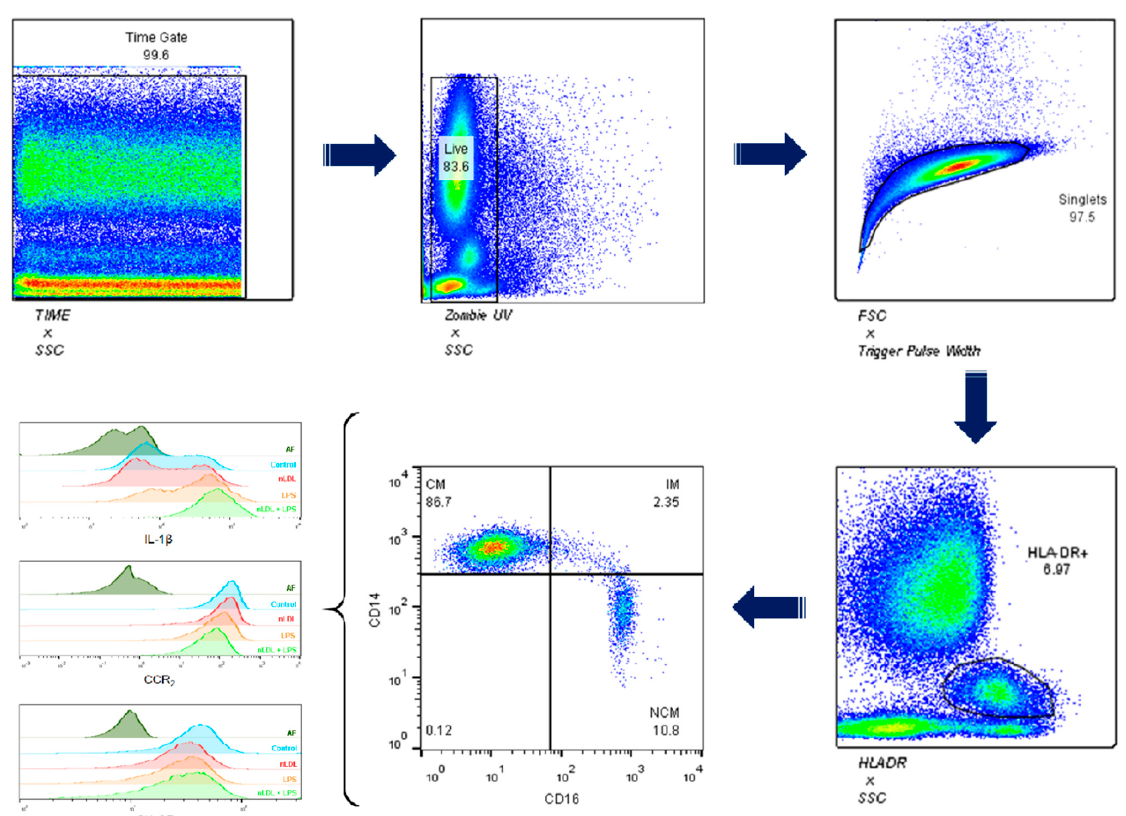
Figure 1. Gating strategy for characterizing human monocyte subsets. White blood cells were first gated on a time/side scatter (SS) density plot, and then gated on the Zombie UV negative cell population for detection of living cells. After- wards, living cells were gated for singlets on a forward scatter (FS)/Trigger Pulse Width density plot. Monocytes were recognized on the HLA-DR gating. Then, monocytes were gated on the CD14+/CD16+ population for identification of CMs (CD14++CD16 − ), IMs (CD14++CD16+), and NCMs (CD14+CD16+). Expression of IL-1 beta, CCR2, and CX3CR1 was measured in all monocyte subsets. SSC, side scatter; FSC, forward scatter; HLA-DR, human leukocyte antigen-DR isotype; CM, classical monocytes; IM, intermediate monocytes; NCM, non-classical monocytes; IL-1 beta, interleukin 1 beta; CCR2, C-C chemokine receptor type 2; CX3CR1, CX3C chemokine receptor